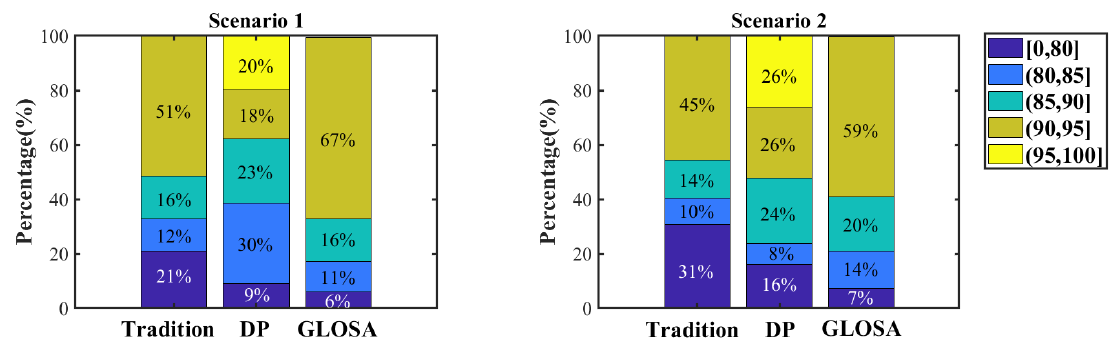
Figure 10. Percentage of the number of operating points in each efficiency area.